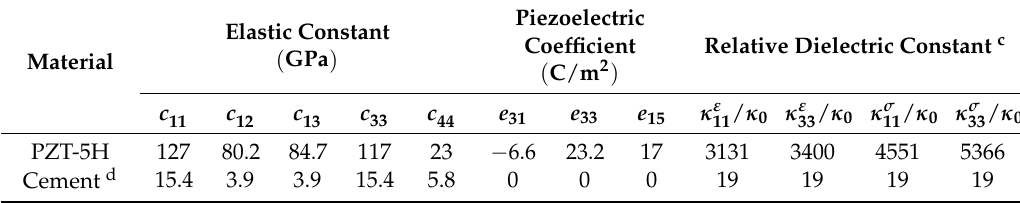
Table 1. Material properties of the considered composites a,b